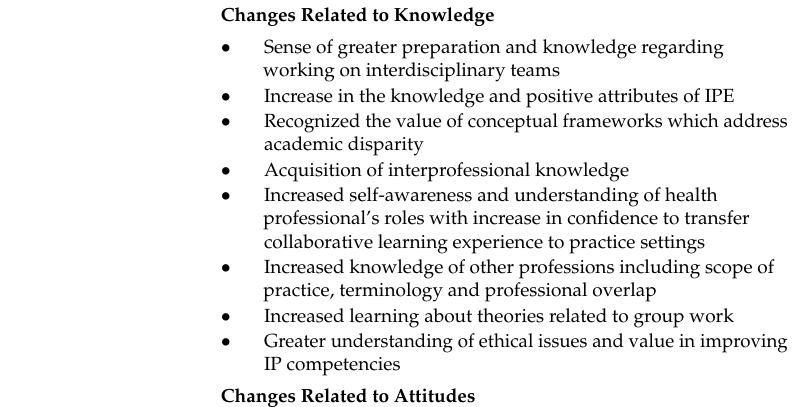
Table 3. Positive Outcomes and Challenges Related to IPC in Health Care